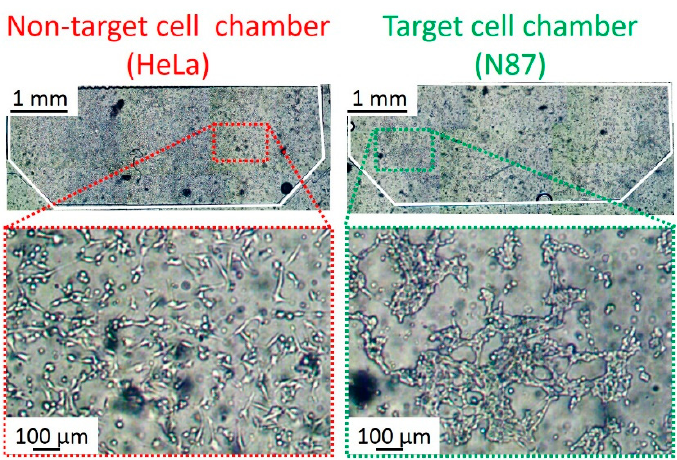
Figure 6. Micrographs of the HeLa and N87 cells cultured in the cell chambers. The HeLa and N87 cells were separately cultured in non-target and target cells without cross